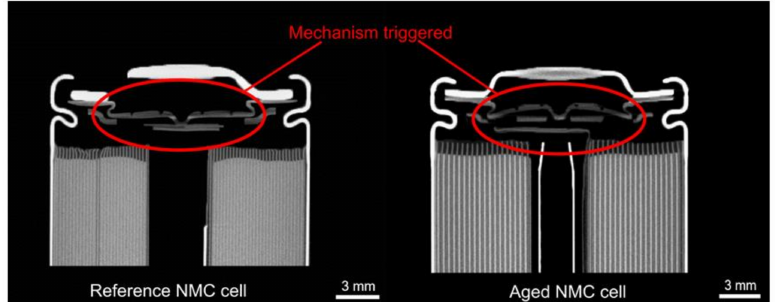
Figure 6. CT scan comparison of a “dead” NMC cell on the right side with an unaged reference cell on the left. The NMC cell was aged at 60 ◦ C and U H storage